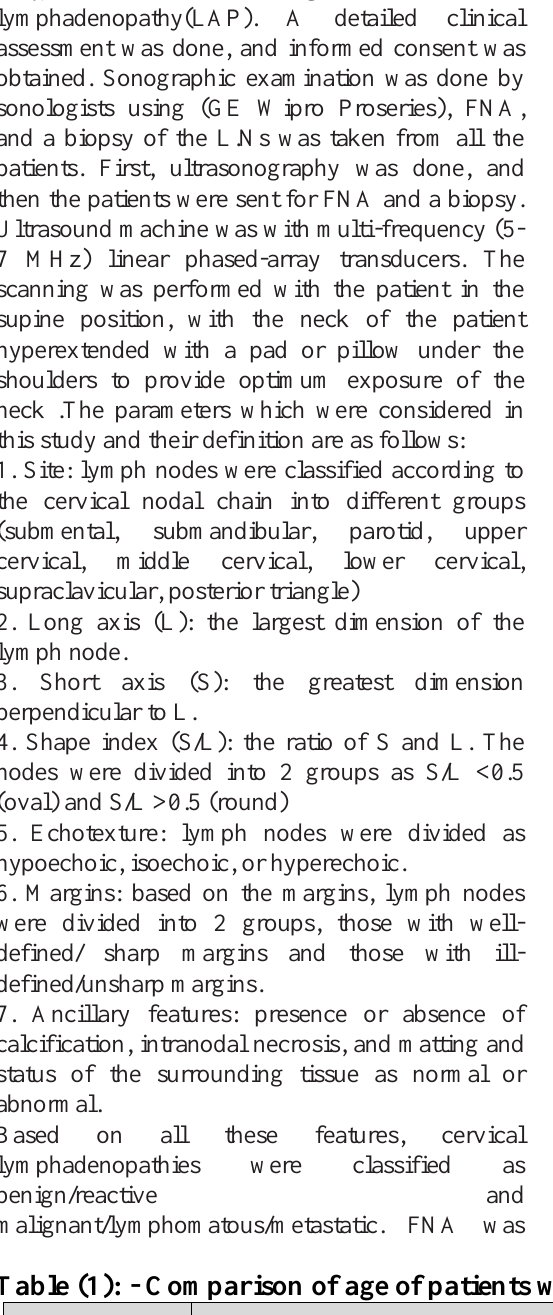
Table (1): - Comparison of age of patients with malignant and benign lymphadenopathy